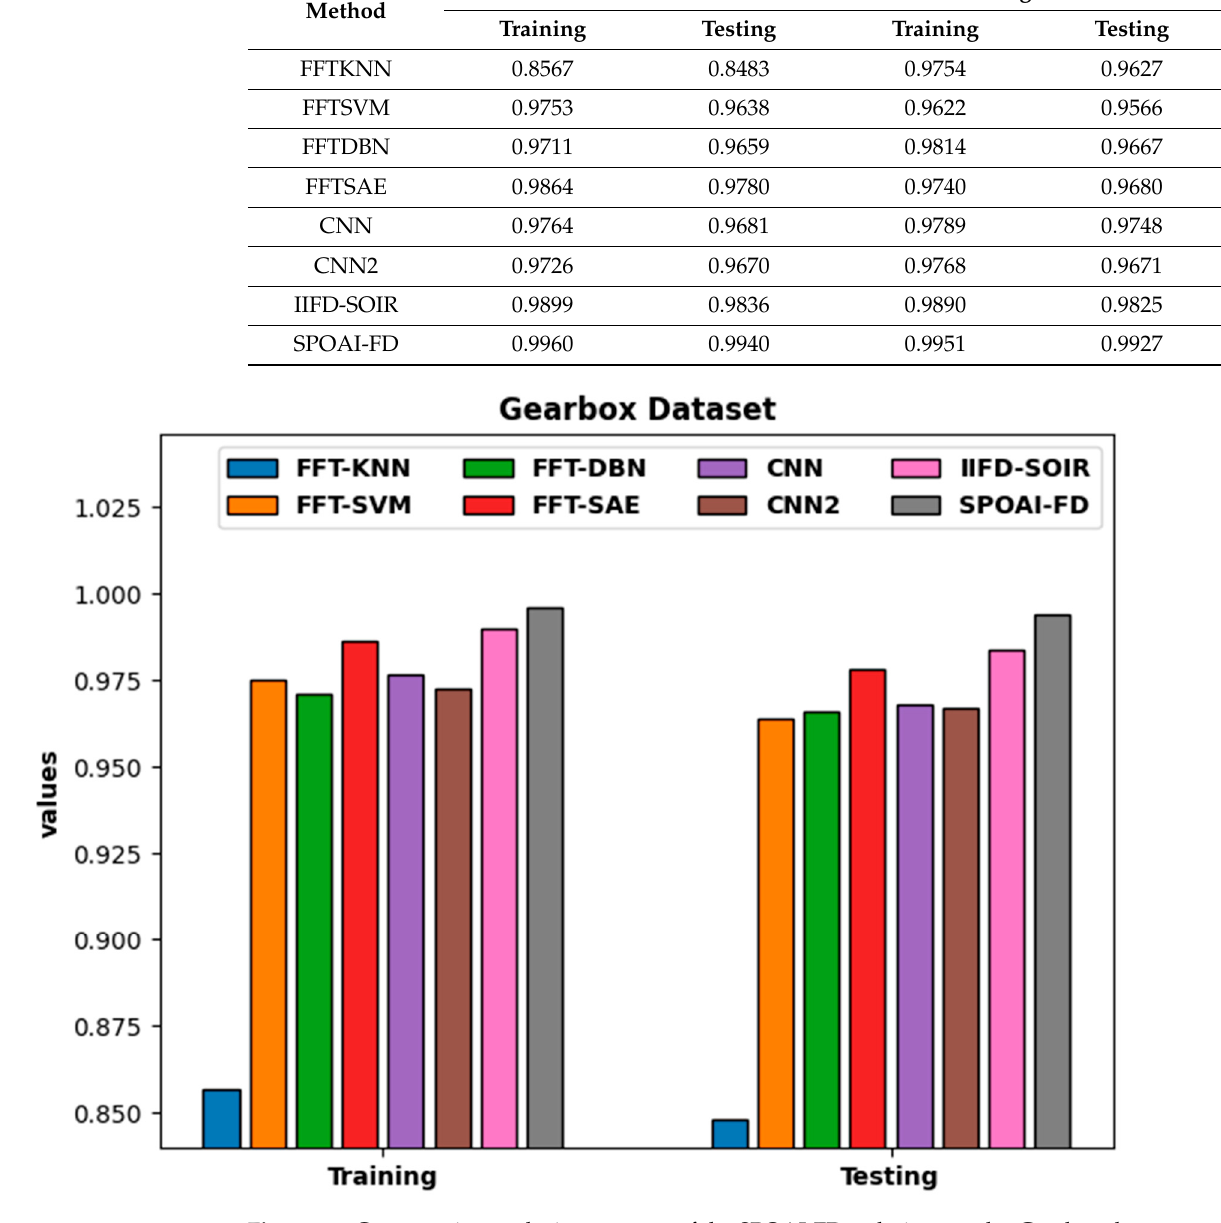
Figure 10. Comparative analysis outcomes of the SPOAI-FD technique under Gearbox